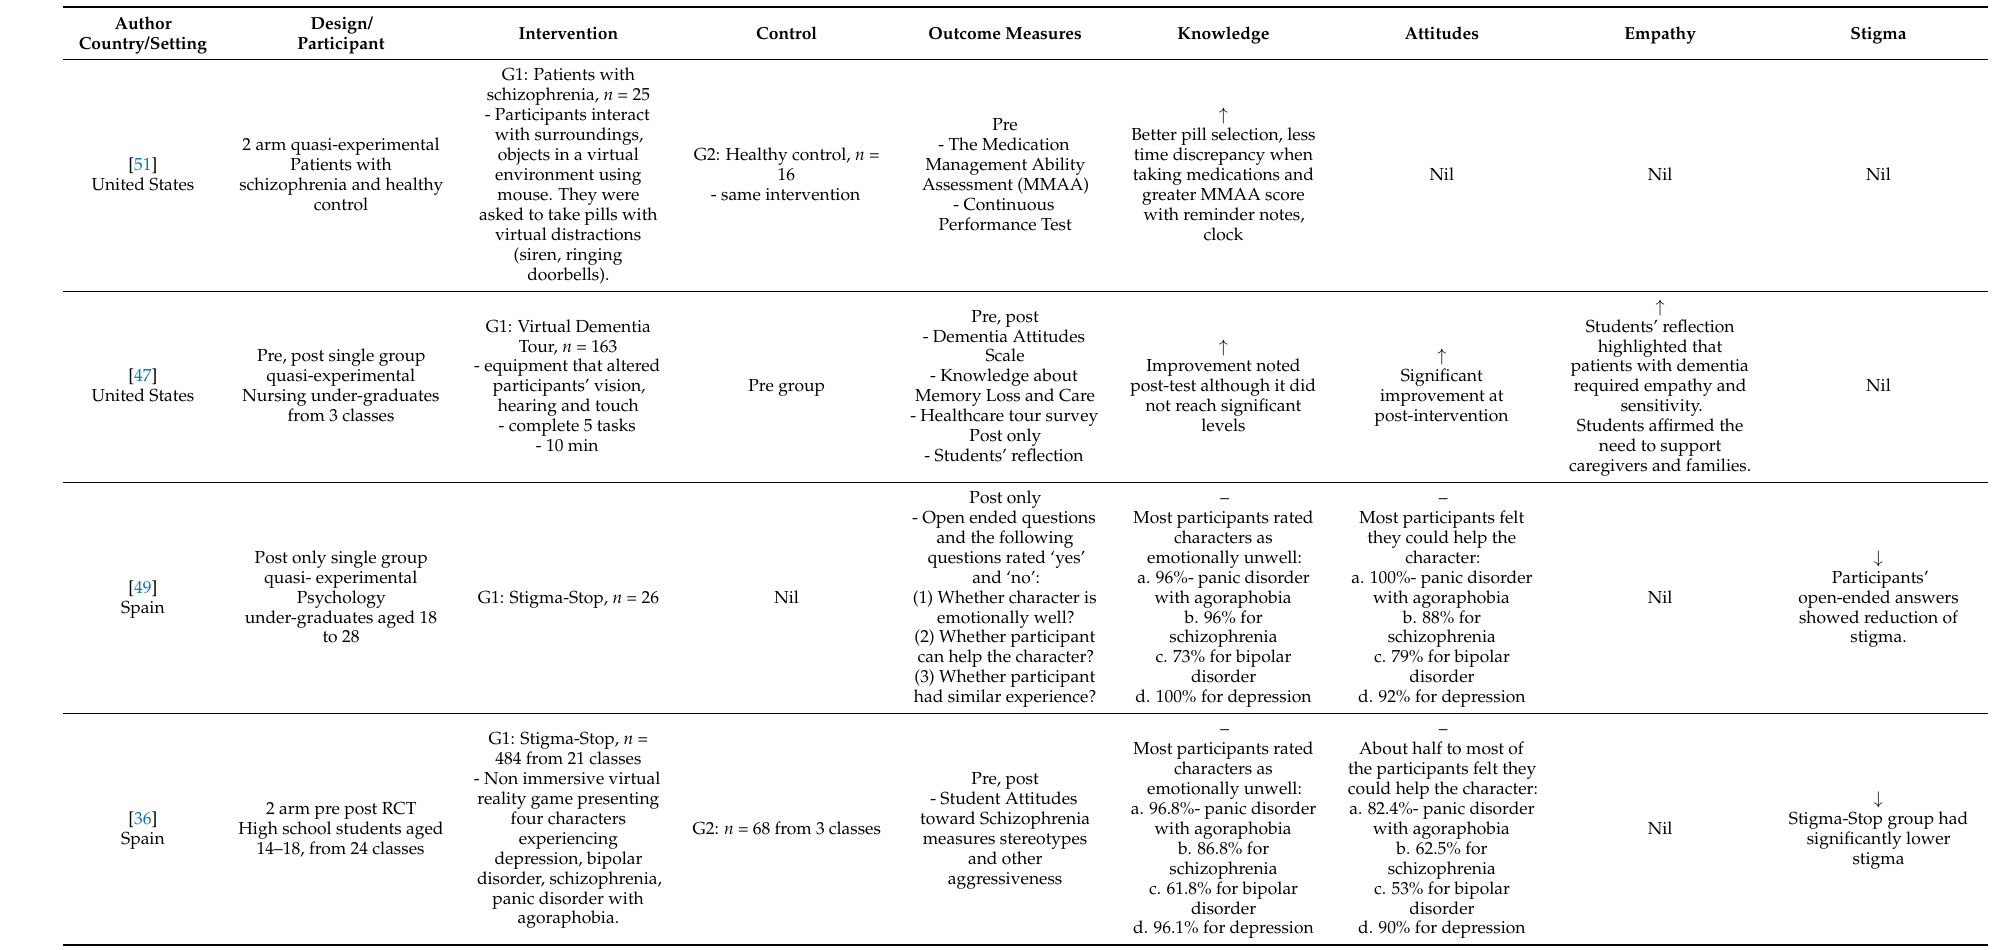
Table 1. Details of included